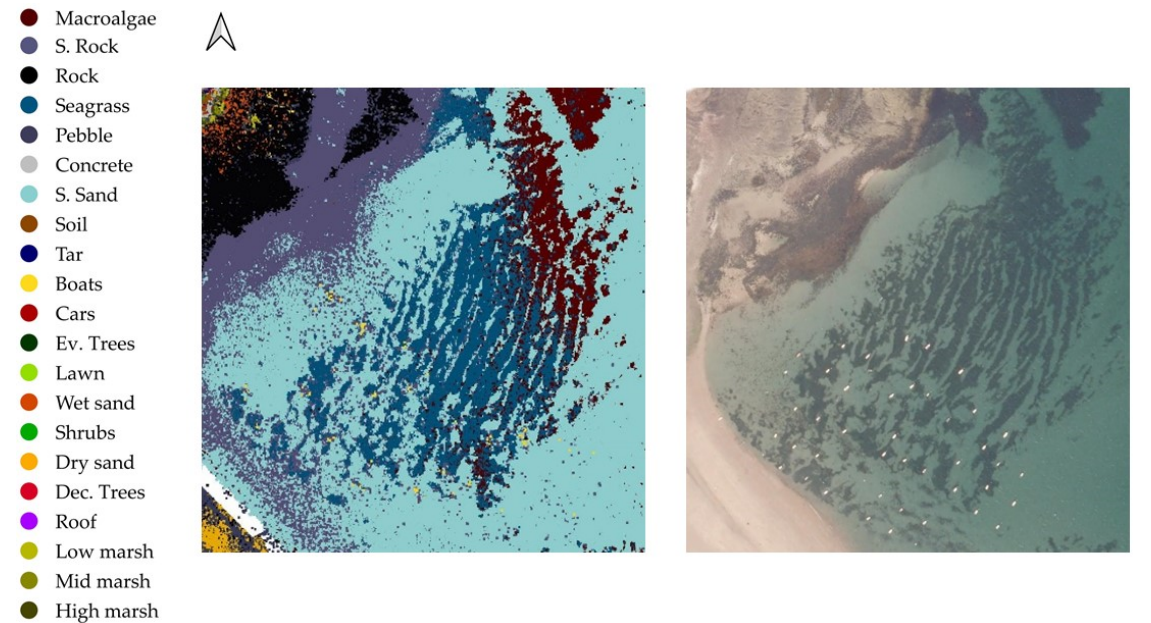
Figure 12. Extract of the projected 3D map of the habitats obtained with the predictions of a ran- dom forest classifier on green spectral features, infrared intensities, and elevation values, and ex- tract of an orthoimage of the same area. The orthoimage was captured in 2014, while lidar data are not contemporaneous as they date from 2019. S. = submerged, Ev. = evergreen, Dec. = deciduous.